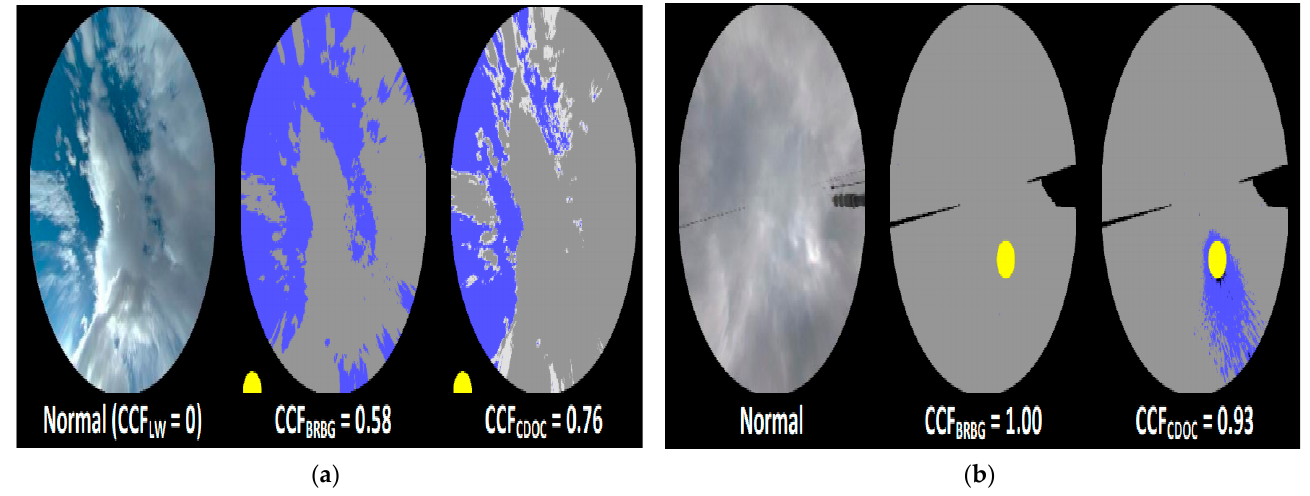
Figure 3. Evaluation of the CCF ratio for the BRBG and CDOC algorithms under two different shading conditions (note, the yellow cycle represents the actual position of the sun in the sky, and the “normal” is the actual image captured using the full-sky imager): ( a ) partial shading, ( b ) overcasting. The normal image captured using the sky imager was an RGB color image (Figure